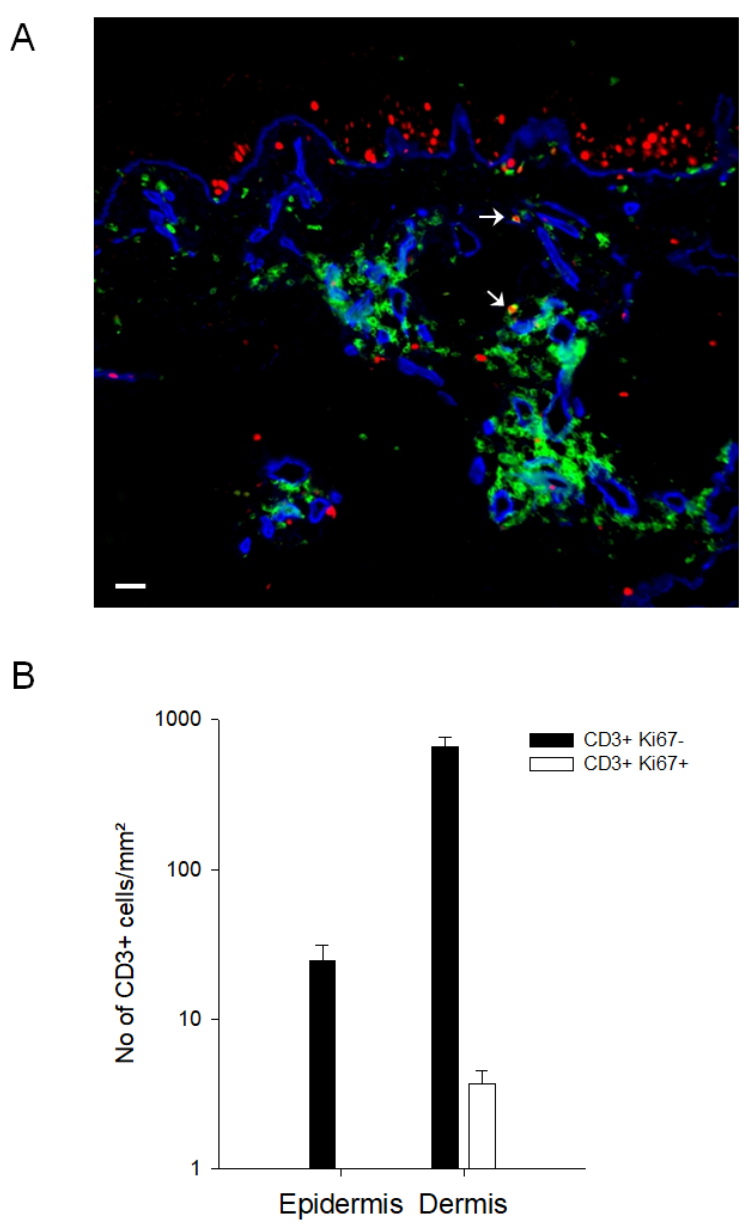
Figure 6. Skin-infiltrating T cells do not proliferate in the skin micromilieu in vivo. Biopsies from patients (n = 6) with a positive nickel-patch test were obtained and analyzed for the expression of Ki67 (red), CD3 (green) and CollagenIV (blue) with the MELC technology. In ( A ), one representative RGB overlay is shown. Arrows mark CD3/Ki67 double positive T cells. Scale bar indicates 20 µm. ( B ) CD3+ Ki67- and CD3+ Ki67+ double positive cells were counted in the epidermis and dermis (n = 6).